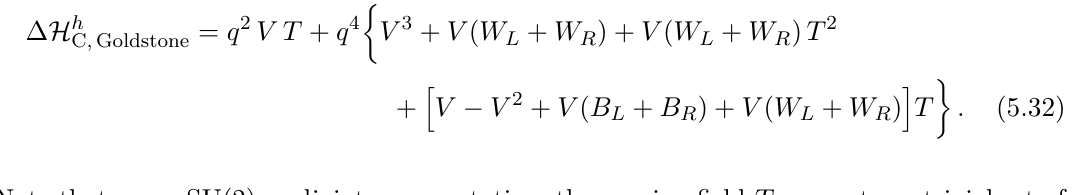
table 5, it leads us